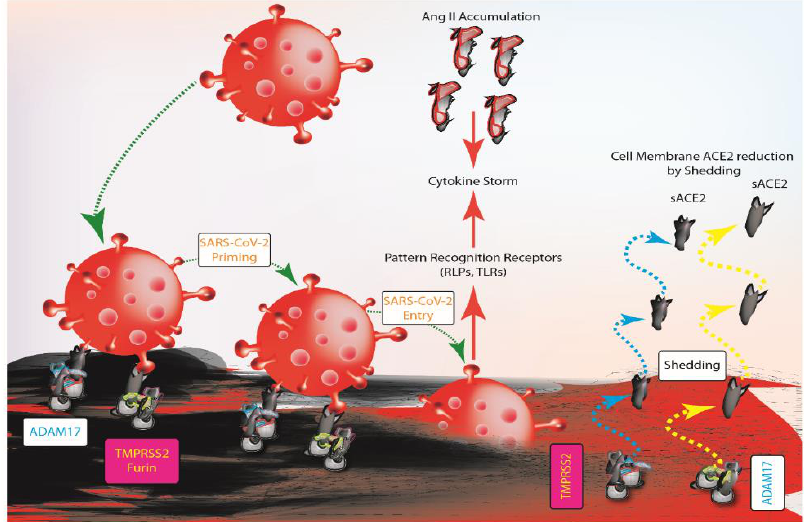
Figure 1. Schematic representation of host cell-SARS-CoV-2 interaction during infection before the interaction between virus and host cell, furin and TMPRSS2 cut the spike (S) protein. The process allows the interaction between S protein and ACE2, which triggers the innate immune response. Ang II contributes to the inflammation sustaining the production of cytokines. ADAM17 and TMPRSS2 mediate the shedding process producing the soluble form of ACE2 thus influencing ACE2 availability on the cell surface and the interaction with SARS-CoV-2. ADAM17, ADAM metallopeptidase domain 17; TMPRSS2, type II transmembrane serine protease; sACE2, soluble ACE2; Ang II, angiotensin II; RLRs, RIG-like receptors; TLRs, toll-like